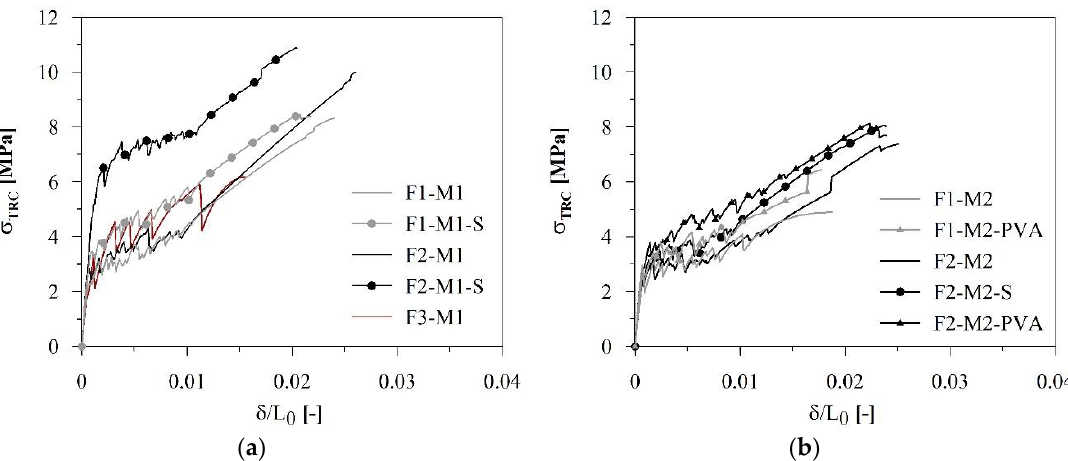
Figure 5. Average tensile response in terms of nominal stress vs. normalised displacement for M1-based ( a ) and M2-based ( b ) composites reinforced with Fabrics F1–F3 (warp direction).